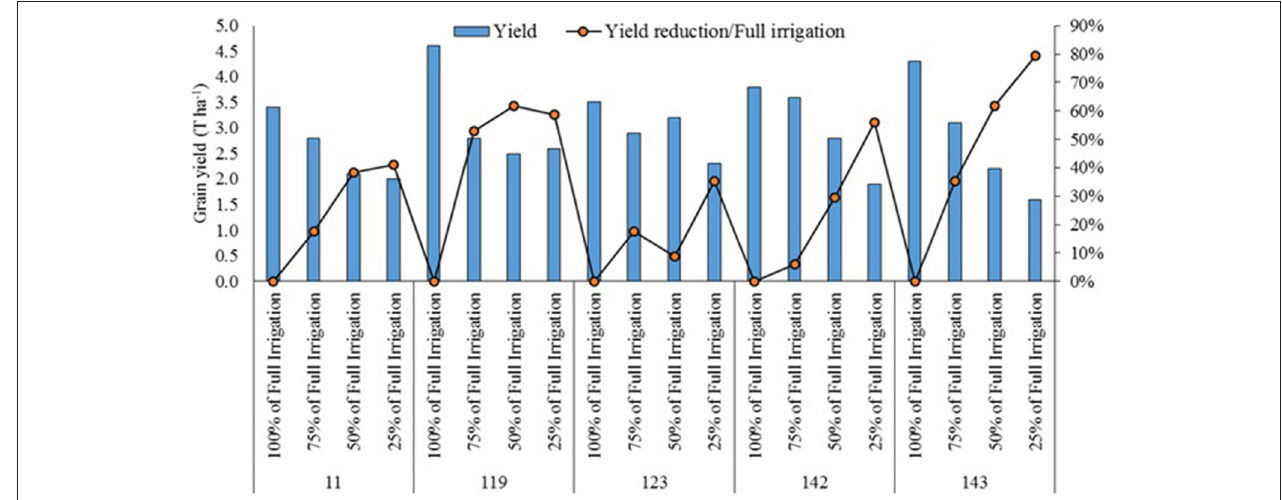
FIGURE 4 | Responses of 5 quinoa lines to different irrigation levels in terms of yield (Filali,